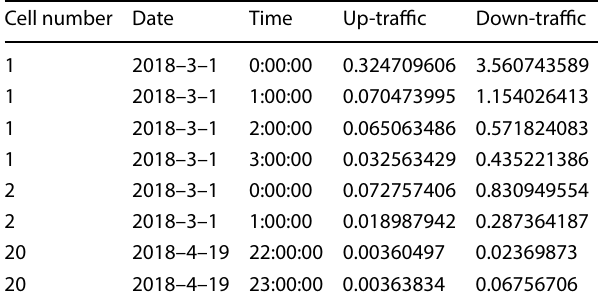
Table 1 Partial data of cell up-down-traffic